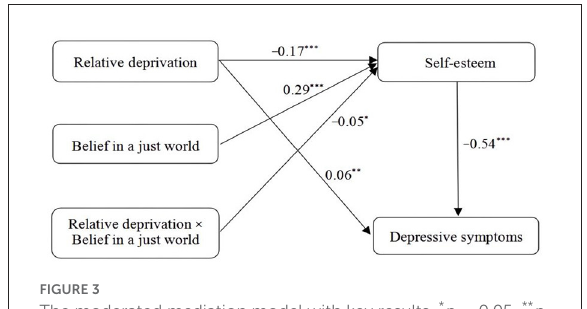
FIGURE3 The moderated mediation model with key results. * p < 0.05, ** p < 0.01, *** p <